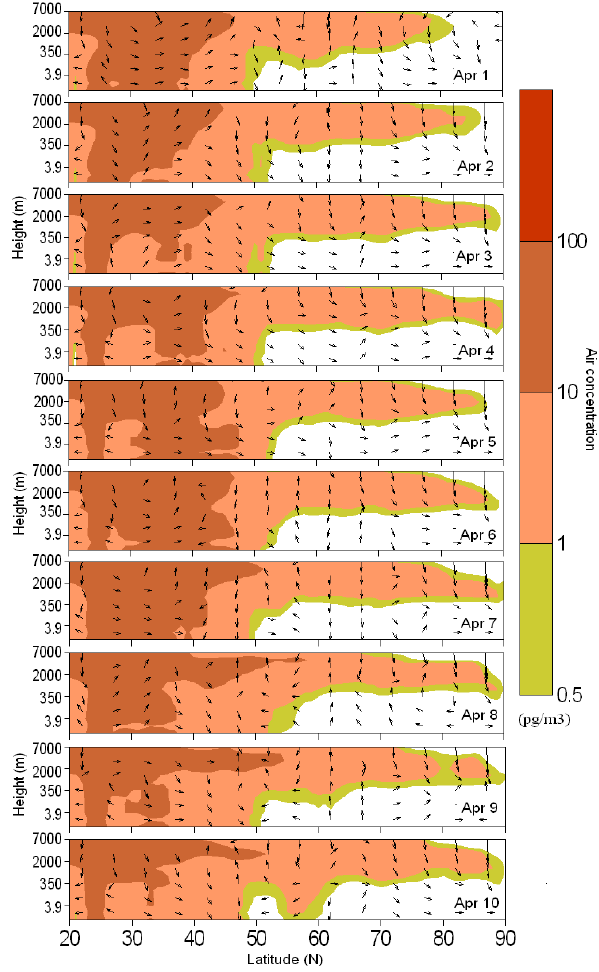
Fig. 10 Fig. 10. Vertical cross section of CanMETOP modeled zonal-mean daily lindane air concentration (pgm − 3 ) from the surface to 7000m height for 1–10 April 1997 (from top to bottom), averaged over longitude 110 ◦ E to 140 ◦